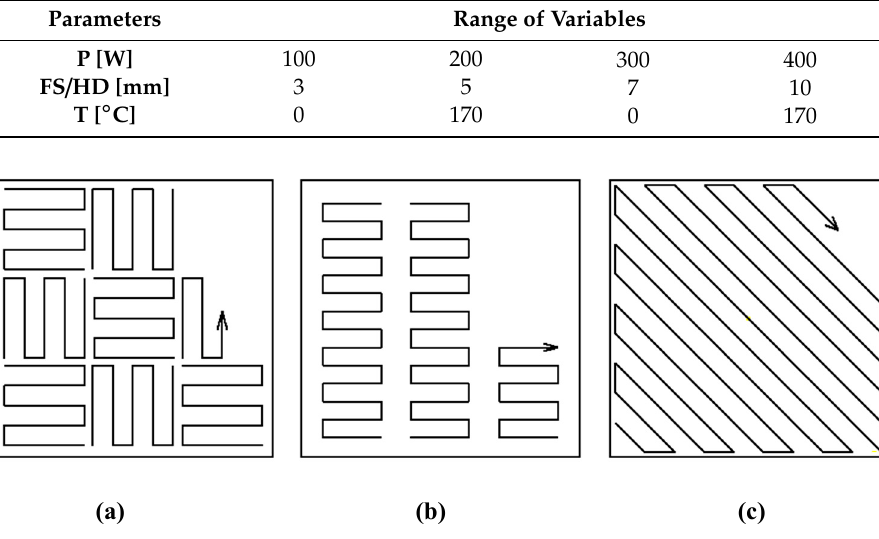
Figure 4 . Chessboard strategy ( a ); Stripes strategy ( b ); Meander strategy ( c ). Figure 4. Chessboard strategy ( a ); Stripes strategy ( b ); Meander strategy ( c